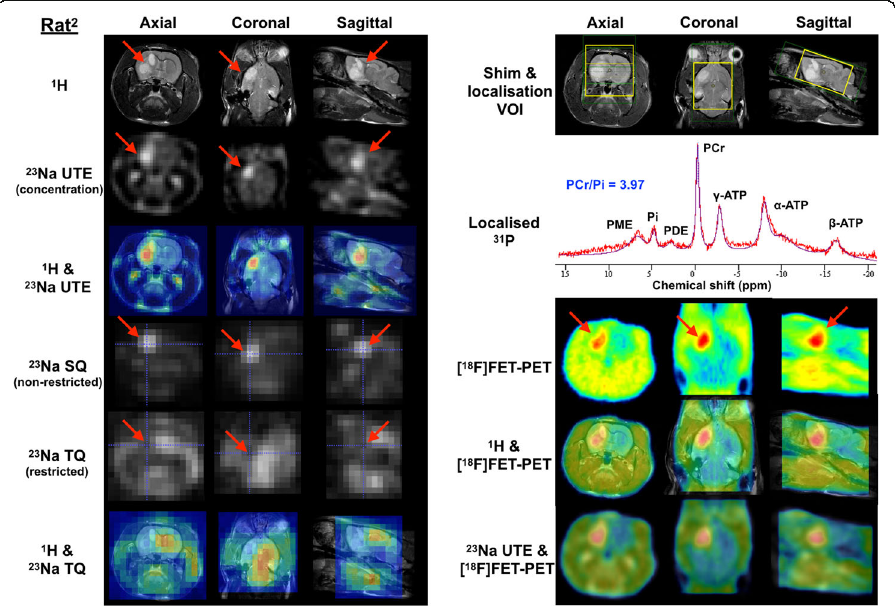
Fig. 3 Axial, coronal and sagittal images of 1 H, ultrashort TE (UTE)/single-quantum (SQ)/triple-quantum- filtered (TQF) 23 Na (left), co-registered MR (bottom left) and [ 18 F]FET-PET images (bottom right) of tumour (pointed out by the red arrow) in vivo rat brain (rat 2 ) together with 31 P MR spectrum with fitting (top right) where the shim-adjusting volume (green box) and 31 P voxel localisation (yellow box) are shown. 23 Na images acquired using UTE, SQ and TQ represent total 23 Na concentration-weighted, non-restricted (mainly extracellular) and restricted (mainly intracellular) 23 Na,